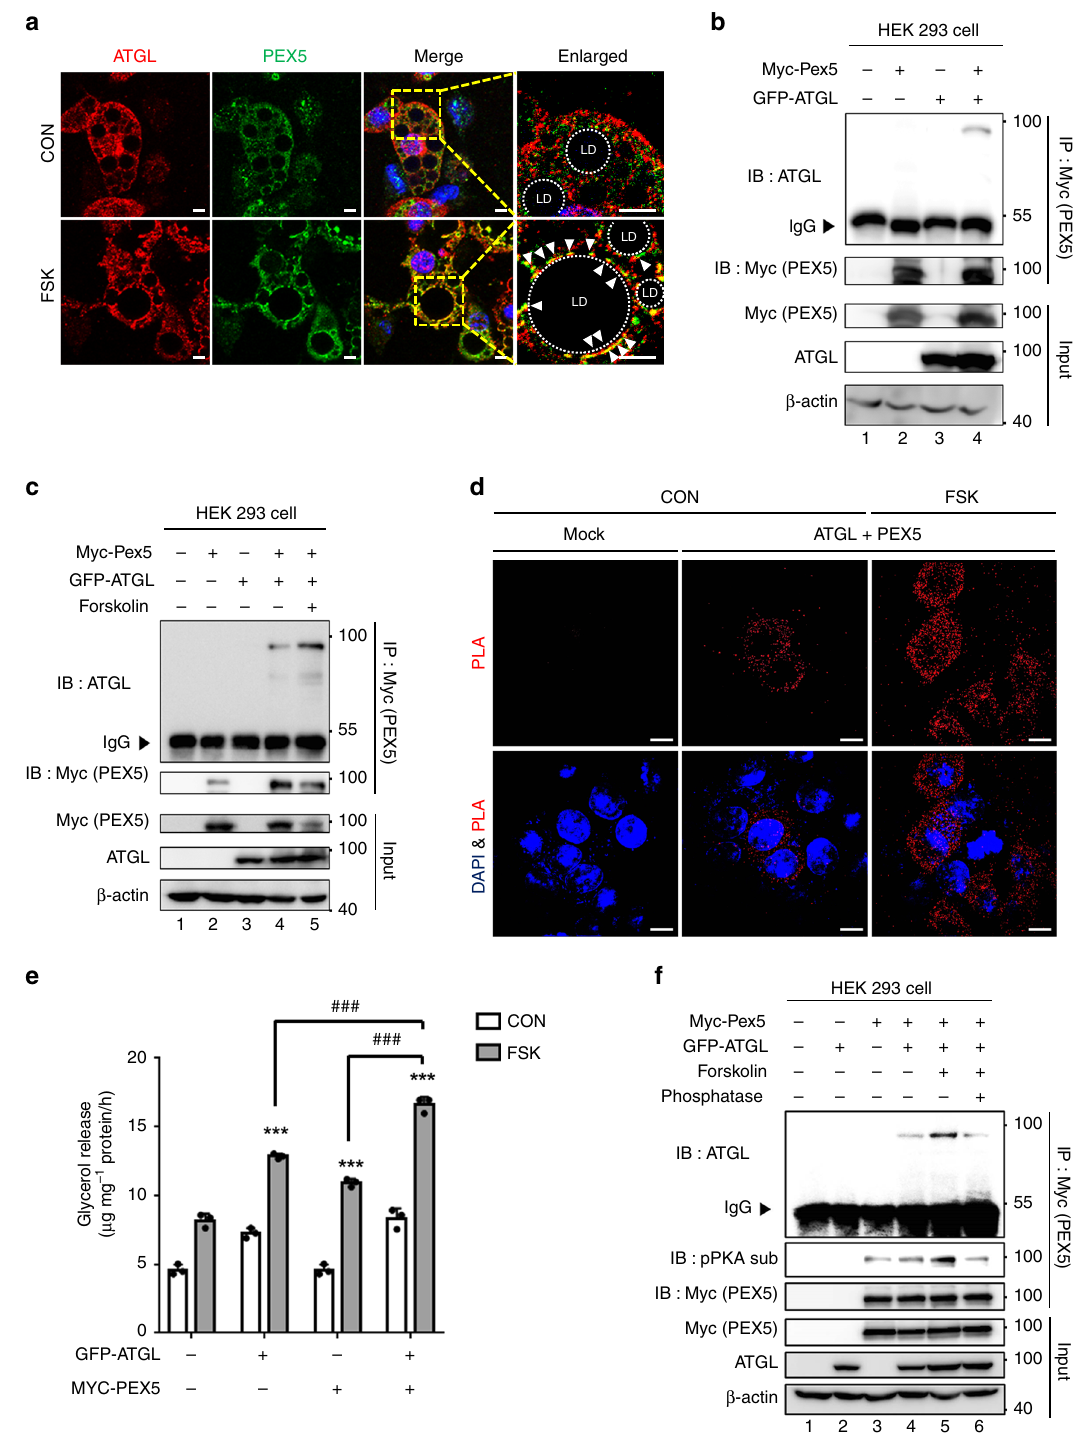
Fig. 6 PEX5 mediates stimulated lipolysis through interaction with ATGL. a Representative images of differentiated adipocytes immunostained for endogenous ATGL (red), PEX5 (green), and DAPI (blue). Adipocytes were treated with or without FSK (10 μ M) for 1 h. CON control; FSK forskolin. Scale bars, 10 μ m. b, c Co-immunoprecipitation with an anti-MYC antibody and western blotting were conducted with the indicated antibodies. HEK293 cells were transfected with MYC-PEX5 and GFP-ATGL expression vectors. FSK forskolin. d In HEK293 cells, in situ proximity ligation (PLA) assay transfected with MYC-PEX5 and GFP-ATGL expression vectors without lipid challenge. FSK forskolin. Scale bars, 10 μ m. e Concentrations of released glycerol from cultured COS-7 cells transfected with or without PEX5-WT and ATGL-WT expression vectors. COS-7 cells were pretreated with oleic acid (500 μ M) for 48 h and FSK (25 μ M) for 3 h. n = 3 for each group. CON control; FSK forskolin. Data represent the mean ± SD; *** P < 0.001 vs. Mock-CON and ### P < 0.001 group by two-way ANOVA followed by Turkey ’ s post-hoc test. f HEK293 cells were transfected with MYC-PEX5 and GFP-ATGL expression vectors and treated with or without FSK and phosphatase (CIAP). Co-immunoprecipitation with an anti-MYC antibody and western blotting were conducted with the indicated antibodies. IP immunoprecipitation; IB immunoblotting; IgG immunoglobulin